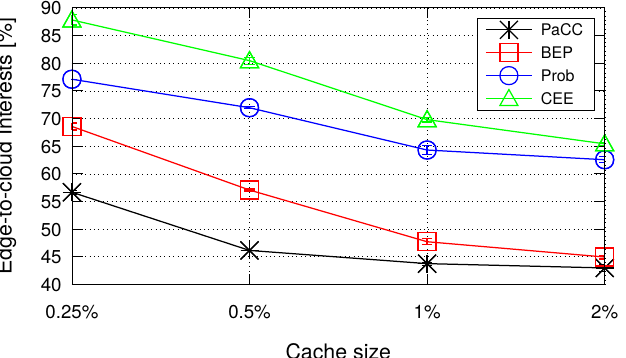
Figure 8. Percentage of Interest packets that are forwarded to the origin